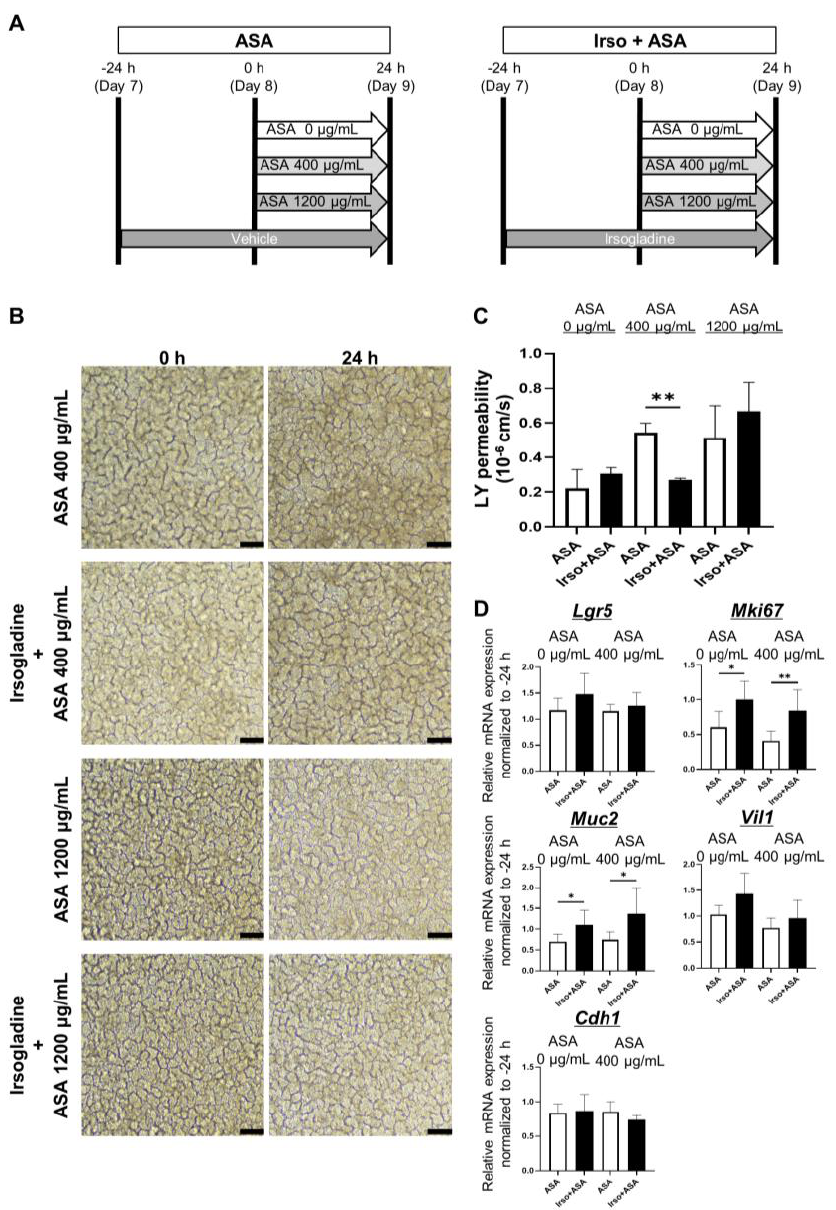
Figure 5. Irsogladine prevented ASA-induced small intestinal injury. ( A ) Protocol for ASA-induced small intestinal injury in 2D-hiPSC-SI. Irsogladine was administered on the basal side of 2D-hiPSC-SI 24 h before ASA addition. Samples were collected 24 h after ASA addition. ( B ) Phase-contrast microscopy. Time-course analysis showed no significant difference in terms of morphological appearance between the ASA groups and Irso + ASA group for both ASA 400 µ g/mL and 1200 µ g/mL. Scale bars, 100 µ m. ( C ) LY permeability of the ASA + Irso group was significantly lower than that of the ASA 400 µ g/mL group ( p < 0.01); mean ± SD; n = 3. ASA 400 µ g/ml treatment significantly increased the LY permeability compared to ASA 0 µ g/ml ( p < 0.01); mean ± SD; n = 3. Statistical analysis was performed using two-tailed Student ’ s t -test; * p < 0.05, ** p < 0.01. ASA; acetylsalicylic acid, Ctrl: control, Irso; Irsogladine, LY: Lucifer yellow. ( D ) Irsogladine significantly increased Mki67 and Muc2 mRNA expression under both normal conditions (ASA 0 µg/mL) and in the pres- ence of 400 µg/mL ASA ( p < 0.05 and p < 0.01; p < 0.05 and p < 0.05, respectively); mean ± SD; n = 6. Statistical analysis was performed using two-tailed Student ’ s t -test; * p < 0.05, ** p < 0.01. ASA: ace- tylsalicylic acid.